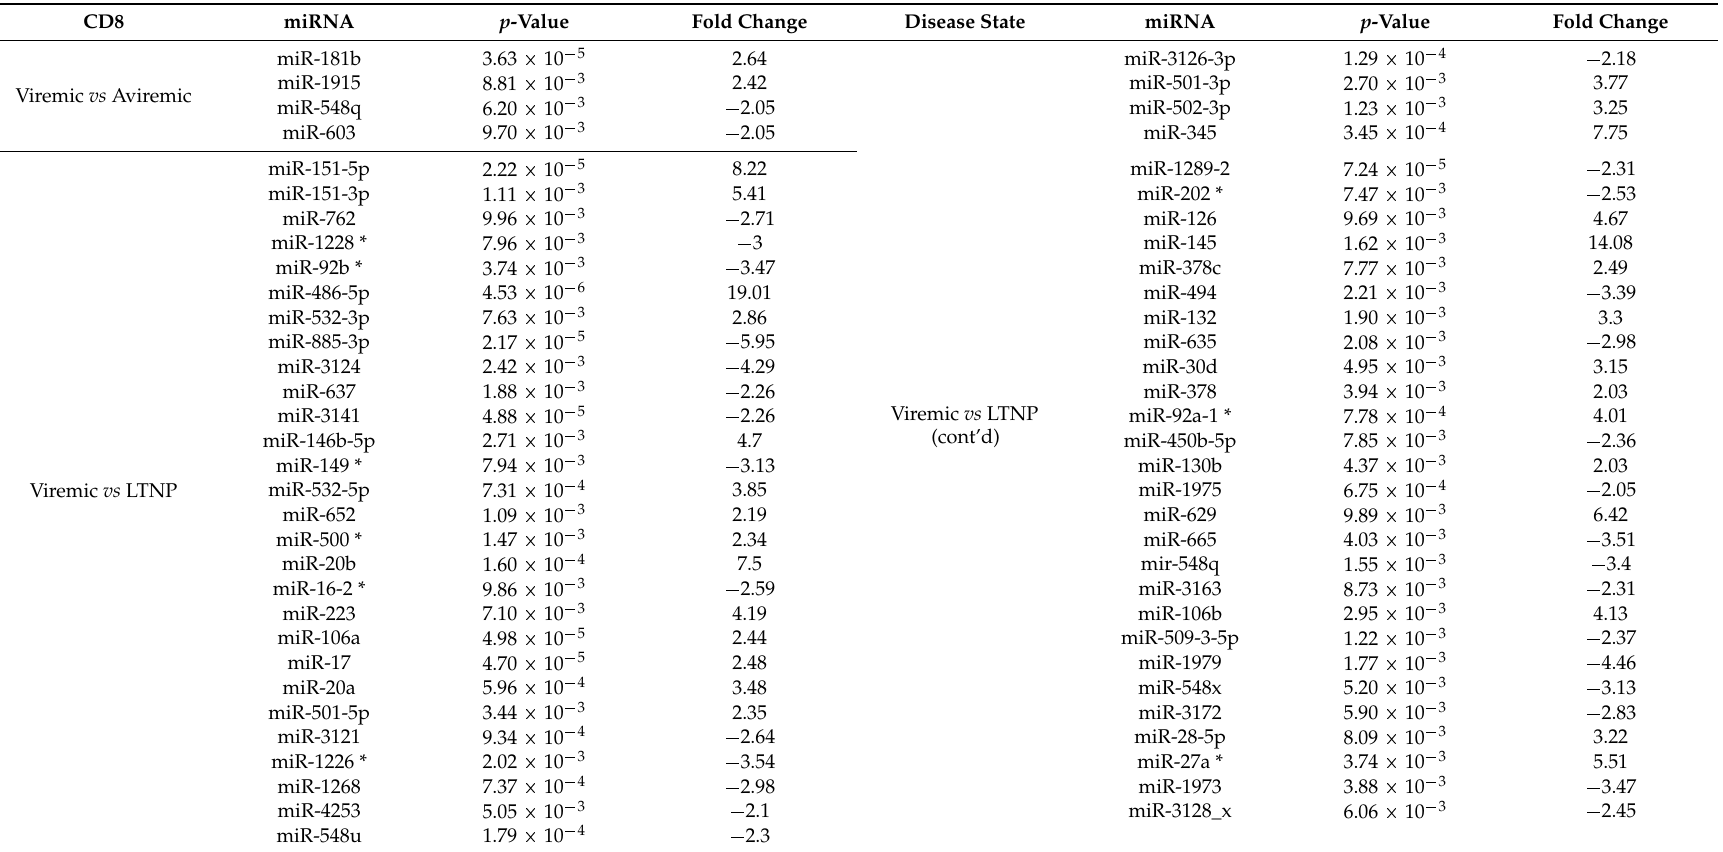
Table A5. Differentially expressed miRNAs when disease classes of CD8+ cells are intercompared.